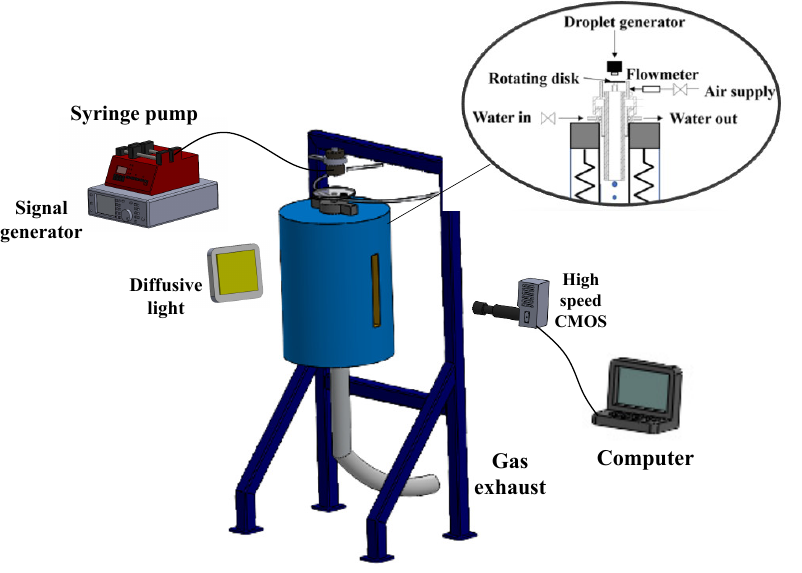
Figure 6. Droplet combustion experimental